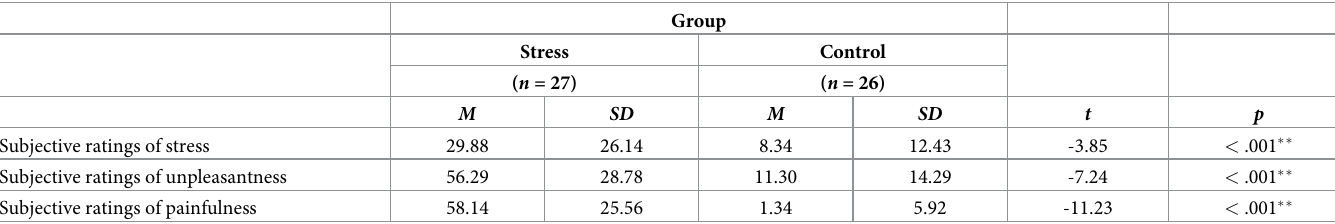
Table 1. Descriptive data of the participants’ subjective stress